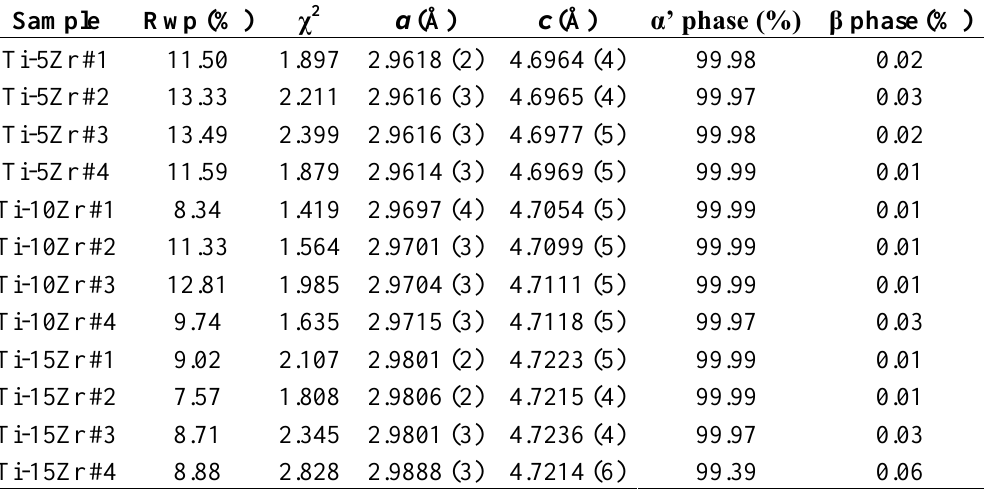
Table 3. Parameters obtained using the Rietveld